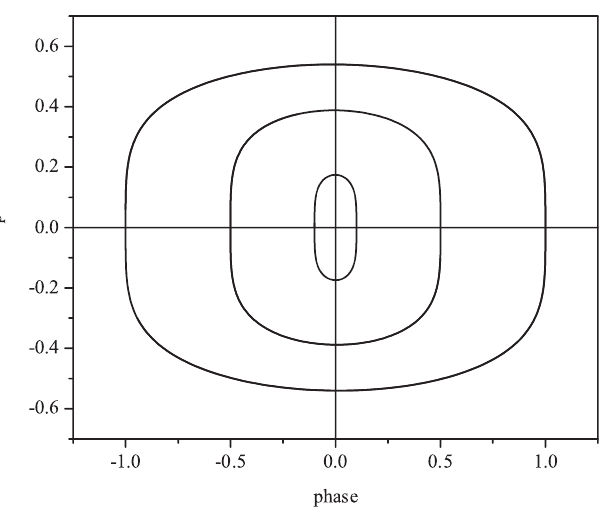
RFPM.FIG. 2. (Color) The rf phase vs